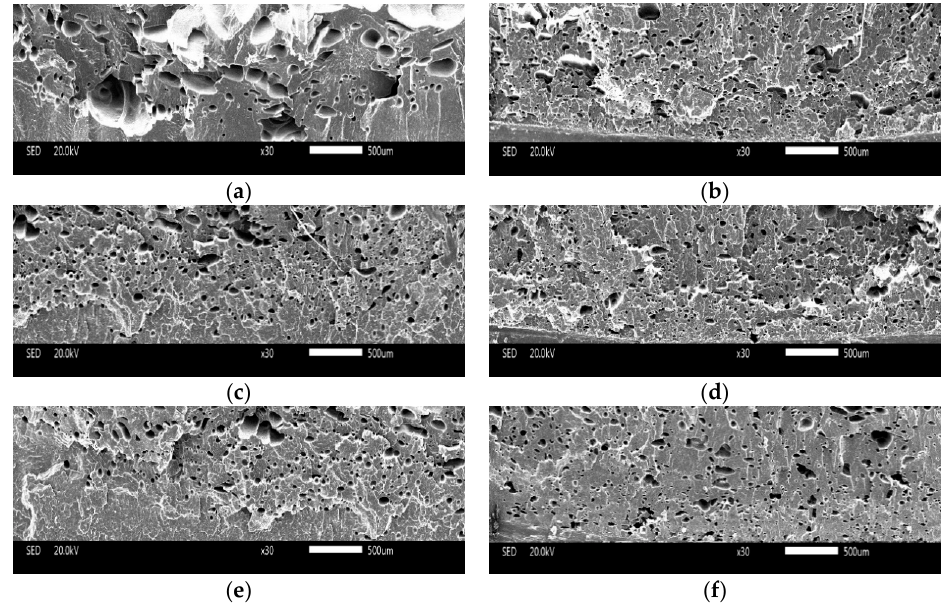
Figure 14. The cells structure of the transition layer of the vertical sections with different contents of nano-CaCO 3 : ( a ) 0 wt % ; ( b ) 2 wt % ; ( c ) 4 wt % ; ( d ) 6 wt % ; ( e ) 8 wt % ; ( f ) 10 wt % .